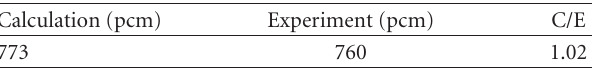
Table 1: Comparison between the measured and calculated subcrit- icalities obtained from the experiments (Figure 1) and calculations (MCNPX with